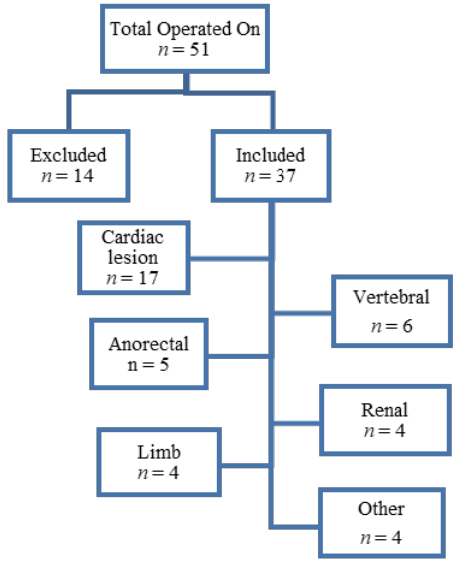
Figure 1. Study flow diagram. Table 1. Neonates demographics ( n = 37).